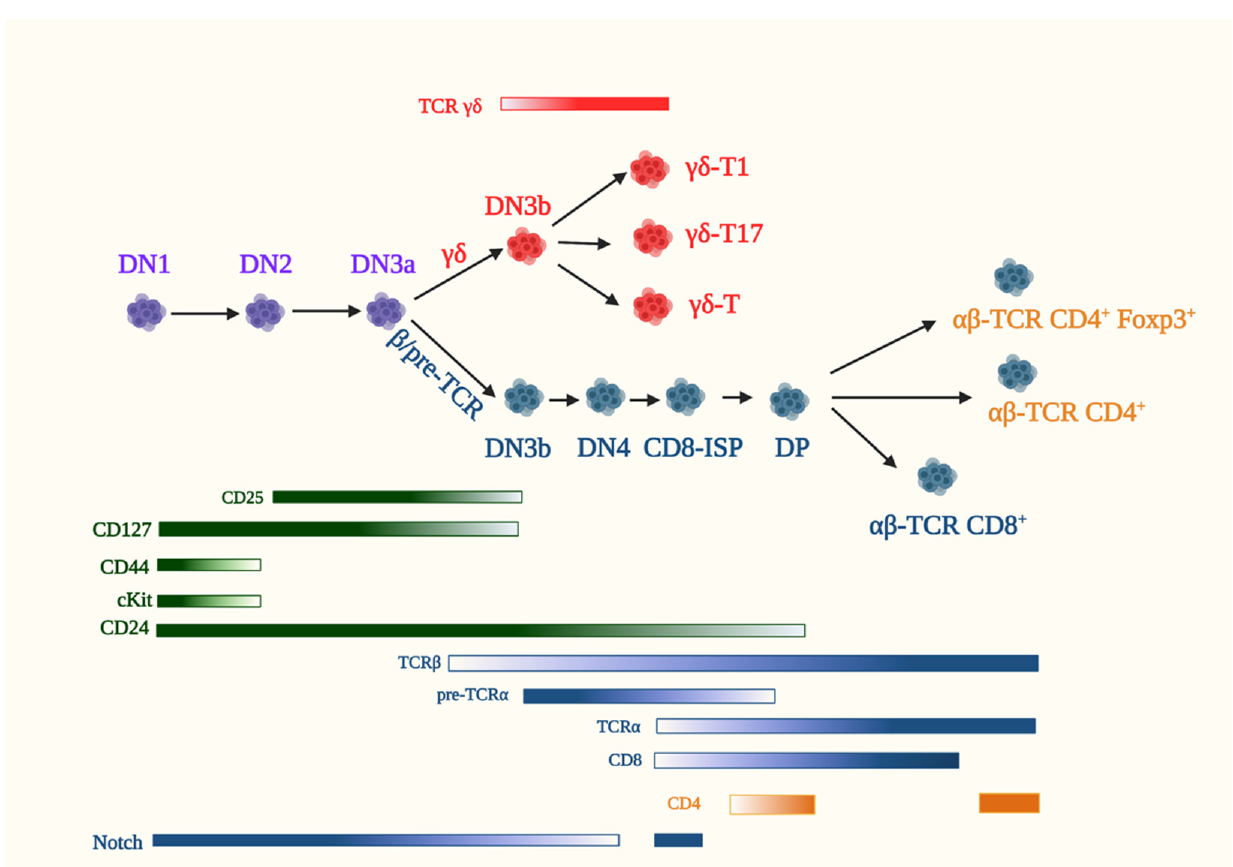
Figure 3. T-cell development in the thymus. Two major types of T cells develop in the thymus, the αβ - and γδ -T cells.